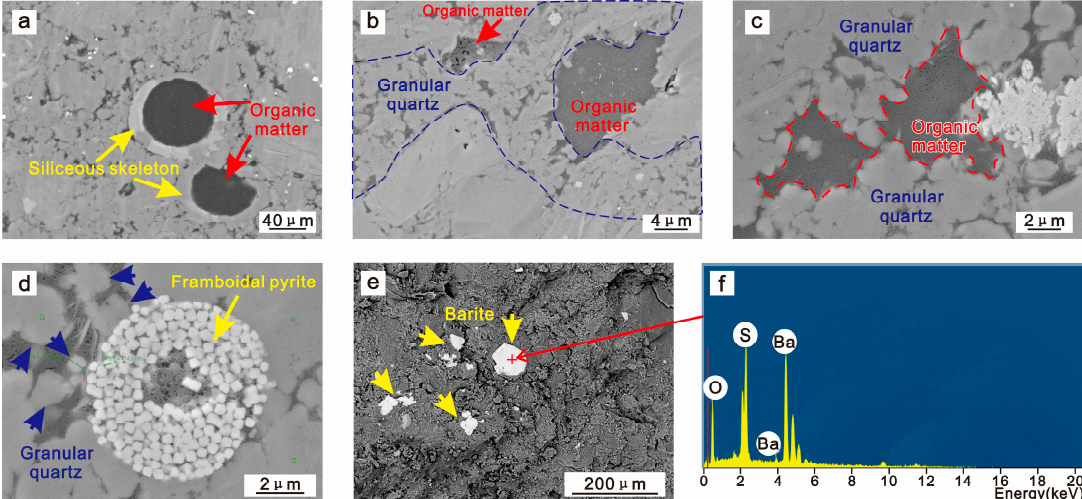
Figure 6. Scanning electron microscopy (SEM) photographs and energy-dispersive spectrum analysis Figure 6. SEM photographs and energy-dispersive spectrum analysis of the organic-rich shales in 242 of the organic-rich shales in the Wufeng and Longmaxi Formations of the Upper Yangtze the Wufeng and Longmaxi Formations of the Upper Yangtze region. 243